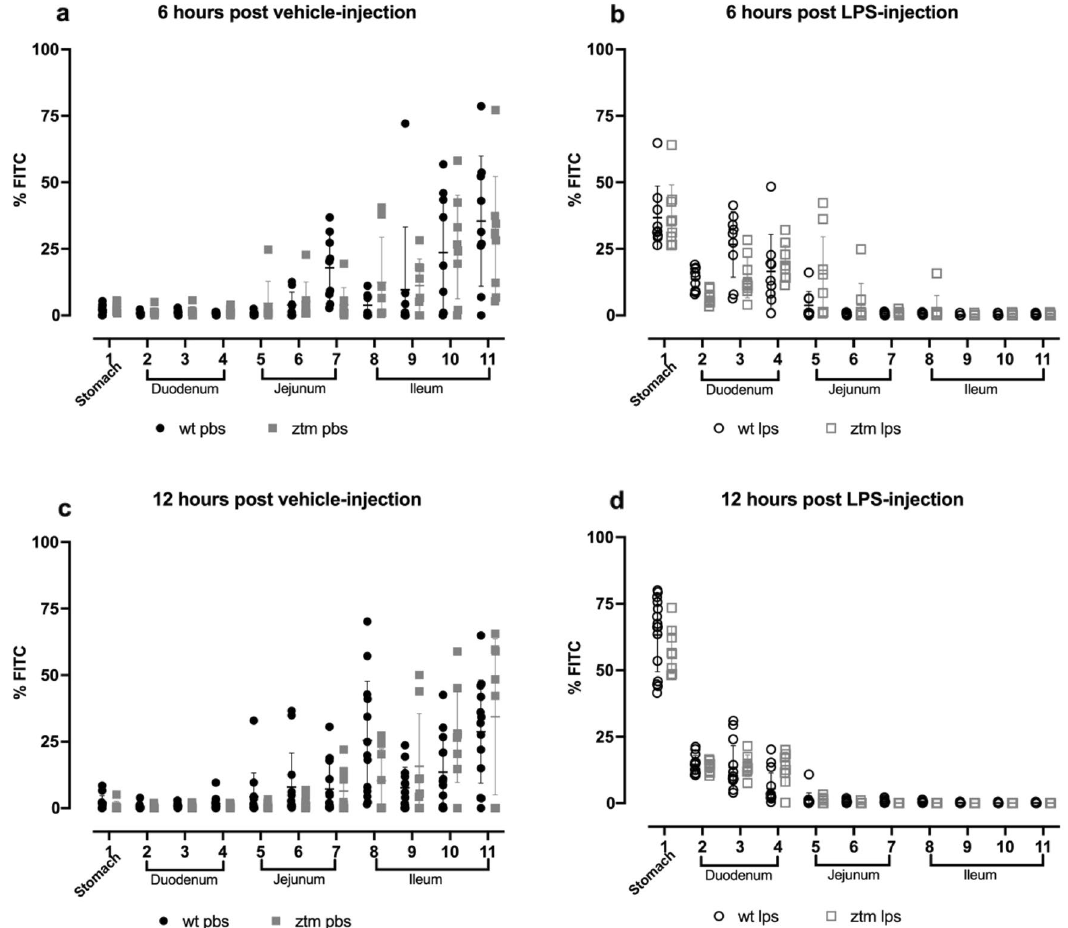
Figure 3. Gastric and small intestine motility measured by FITC-dextran. Mice were gavaged with FITC- dextran, and FITC-dextran signal was measured in the stomach and 10-equal segments of the small intestine at 485/535 nm wavelength 6 or 12 h after vehicle or LPS injection. Individual values per mouse are represented. Filled circles—WT vehicle-injected; Filled squares—Ztm vehicle-injected; Open circles—WT LPS-injected; Open squares—Ztm LPS-injected.